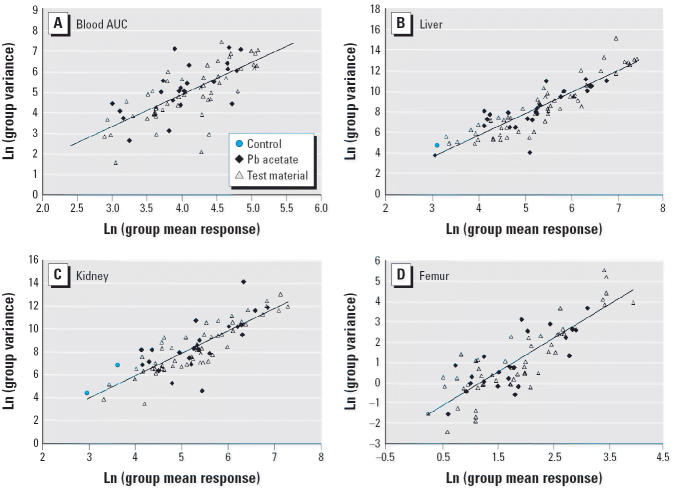
External variance models for (A) blood AUC (y = 1.5516x − 1.3226; R2 = 0.5046; p < 0.01); (B) liver (y = 2.0999x − 2.6015; R2 = 0.7966; p < 0.01); (C) kidney (y = 1.9557x − 1.8499; R2 = 0.7035; p < 0.01); and (D) femur (y = 1.656x − 1.9713; R2 = 0.7022; p < 0.01).